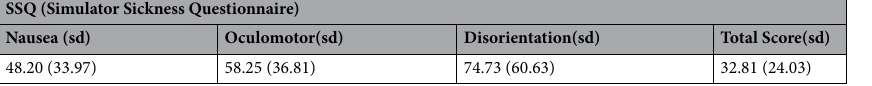
Table 4. Analysis of nausea, oculomotor, disorientation, and total score derived from the SSQ. sd: standard deviation.